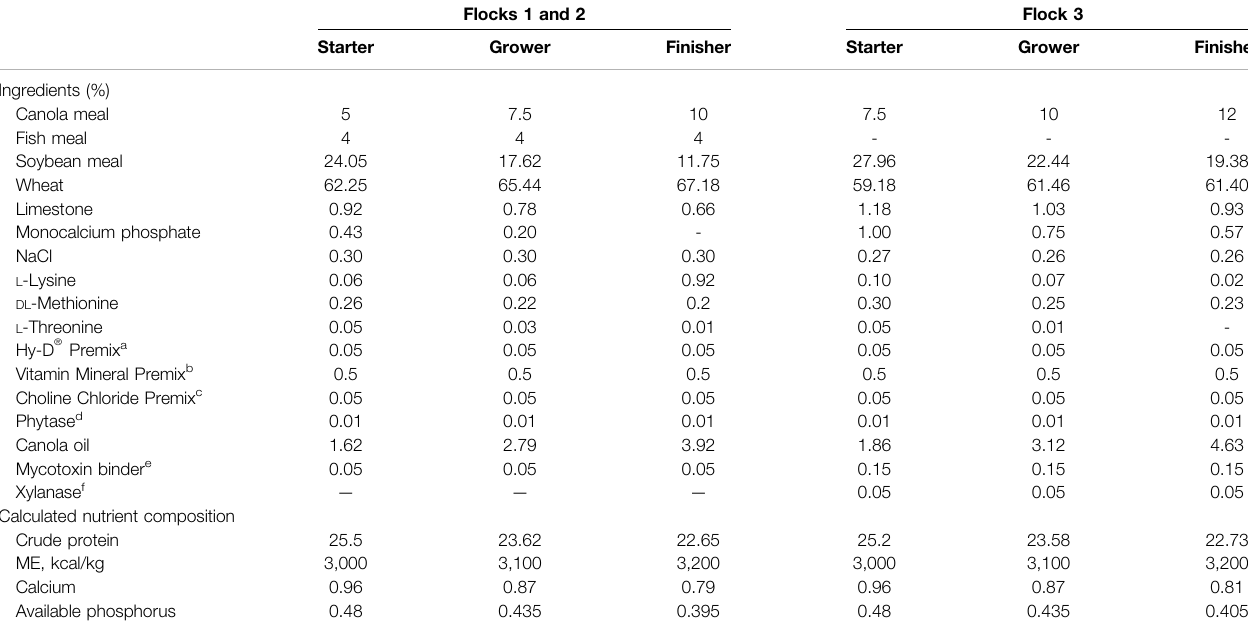
TABLE 1 | Ingredient and calculated nutrient composition of experimental diets for birds during starter, grower, and fi nisher